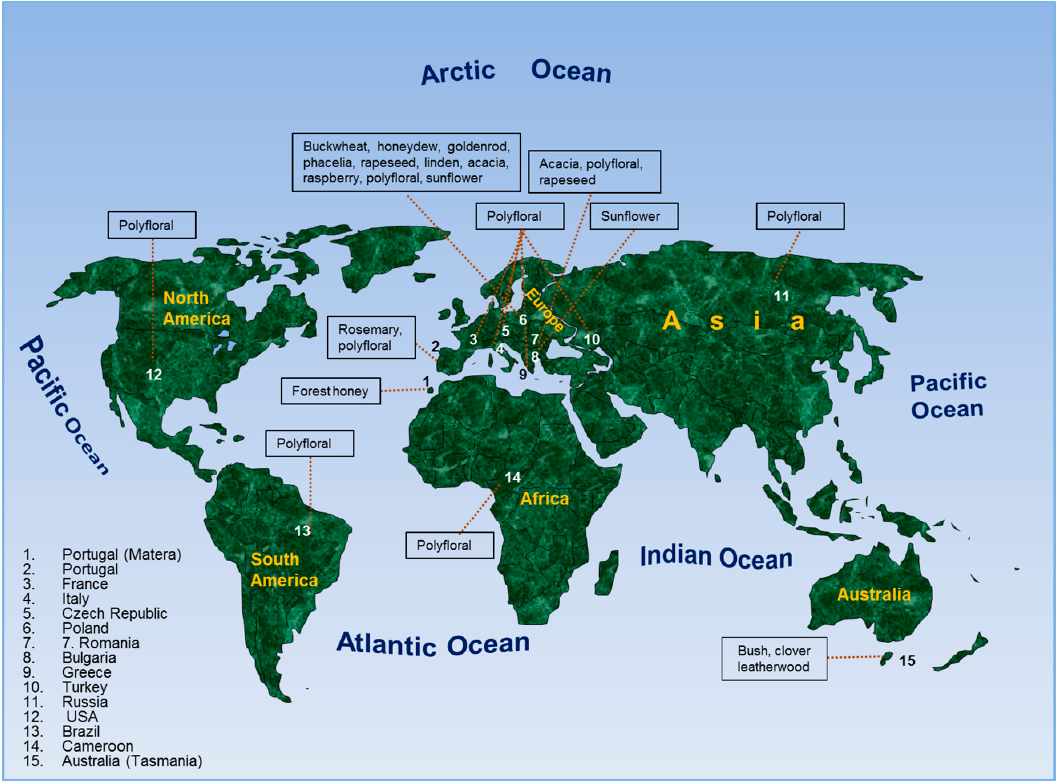
Figure 6. The origin places of honey samples included in the study.